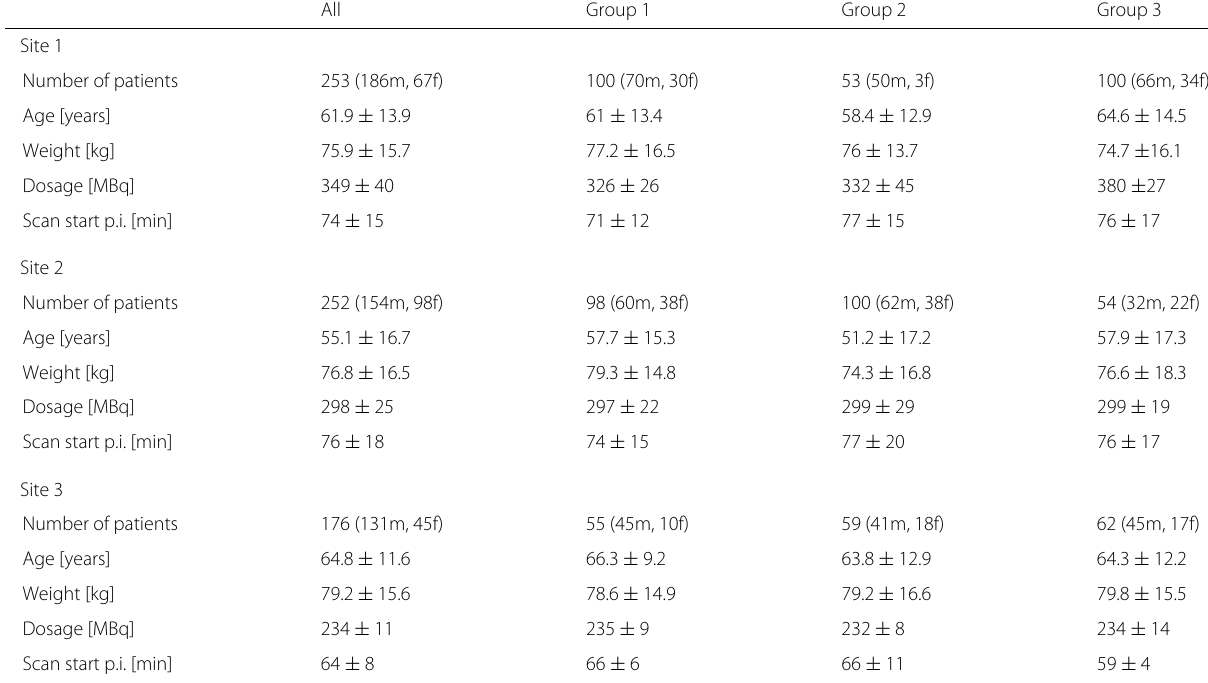
Table 2 Description of patient groups (values expressed as mean ± standard